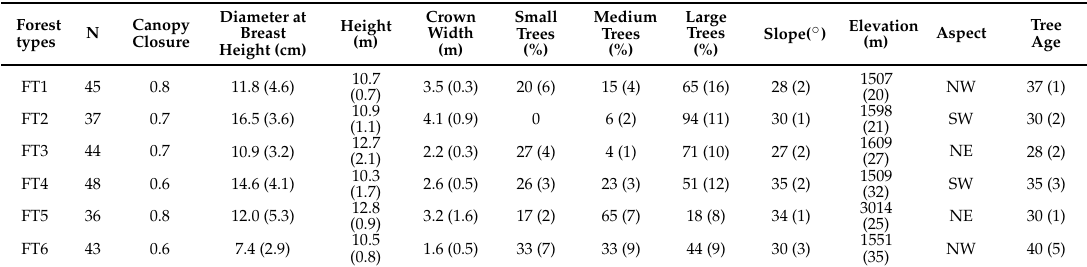
Table 1. Mean of the variables used to describe the six forest types identified in southwest Sichuan Province,